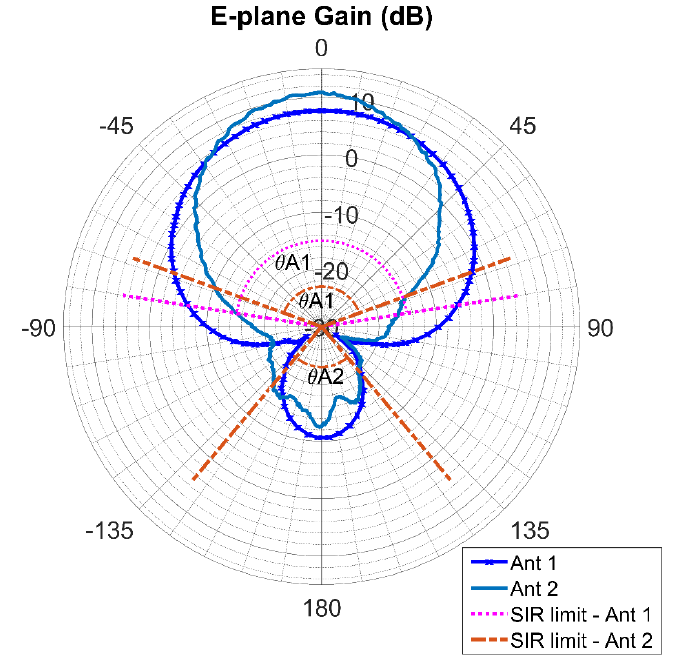
Figure 2. Polar plot of antenna gain pattern for Ant 1 and Ant 2 with its SIR (signal-to-interference ratio) limit angles, where 𝜃 𝐴 = 𝜃 𝐴1 + 𝜃 𝐴2 .